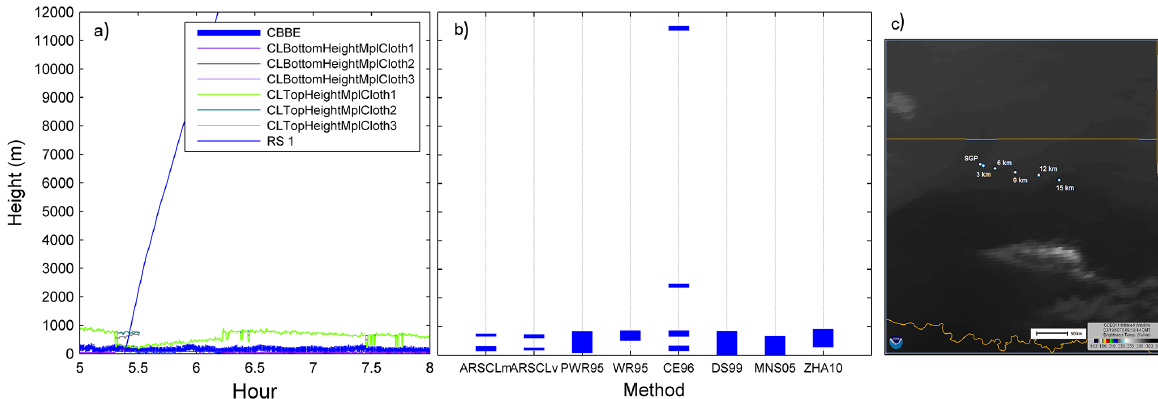
Figure 4. Idem as Fig. 3, but for Case 2: 15 October 2009, low clouds. RS launch time: 05:23UTC. GOES infrared image at 06:00UTC.